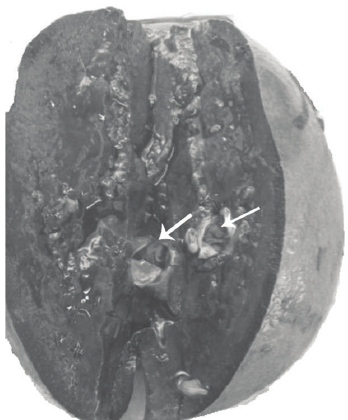
Figure 2: Bisected spleen showing the intrasplenic arterial aneu- rysm (marked by the arrow).